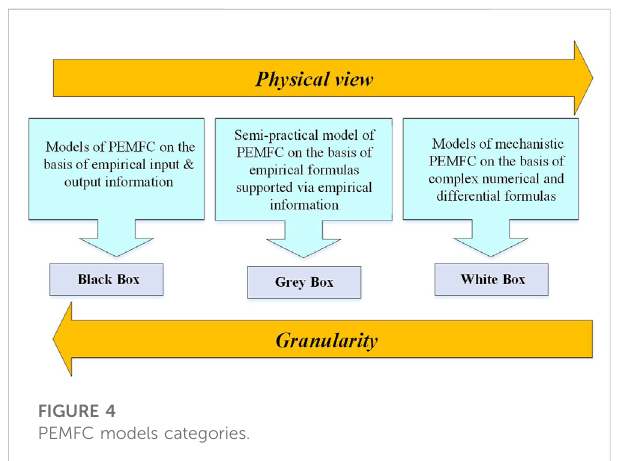
FIGURE 4 PEMFC models